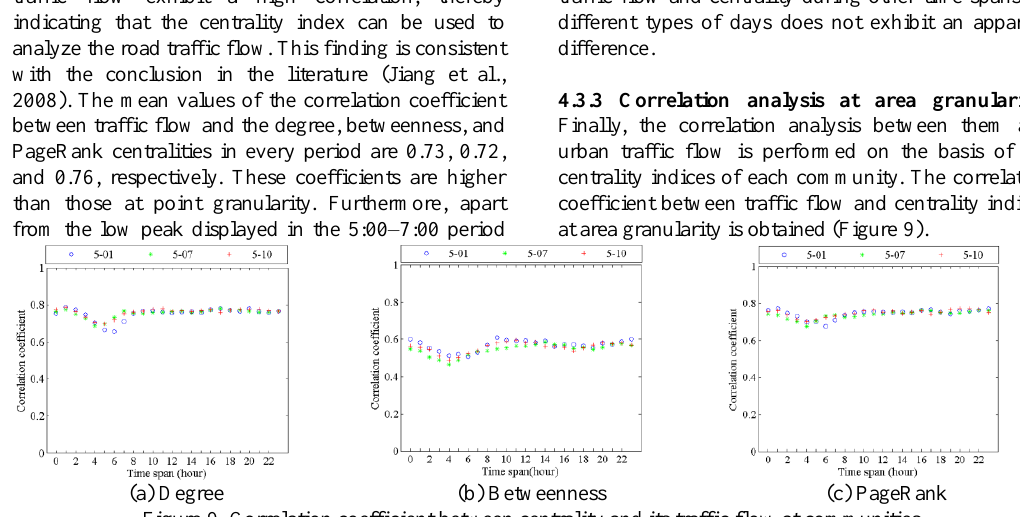
Figure 9. Correlation coefficient between centrality and its traffic flow at